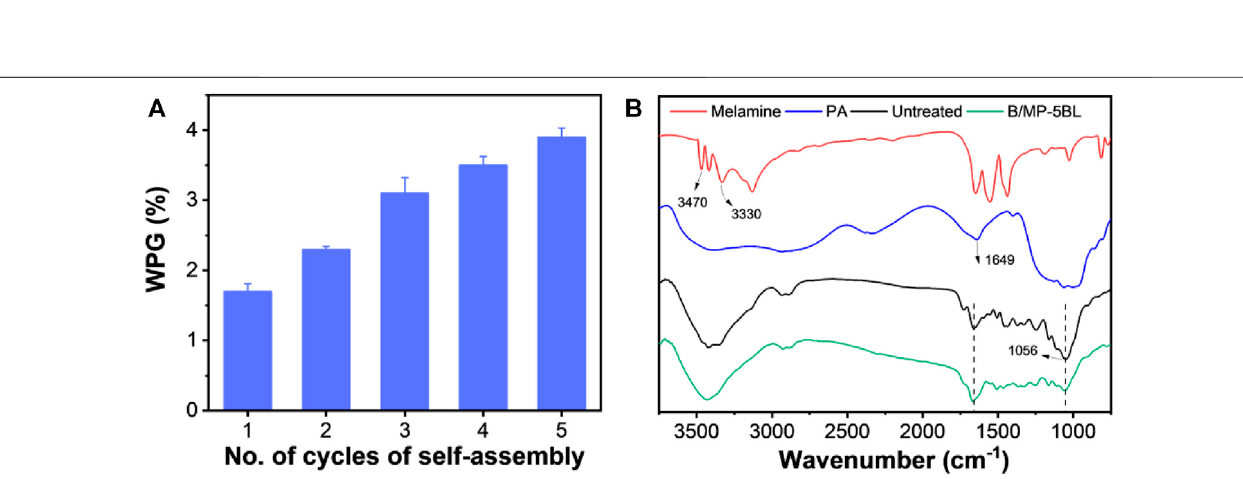
Frontiers in Materials |